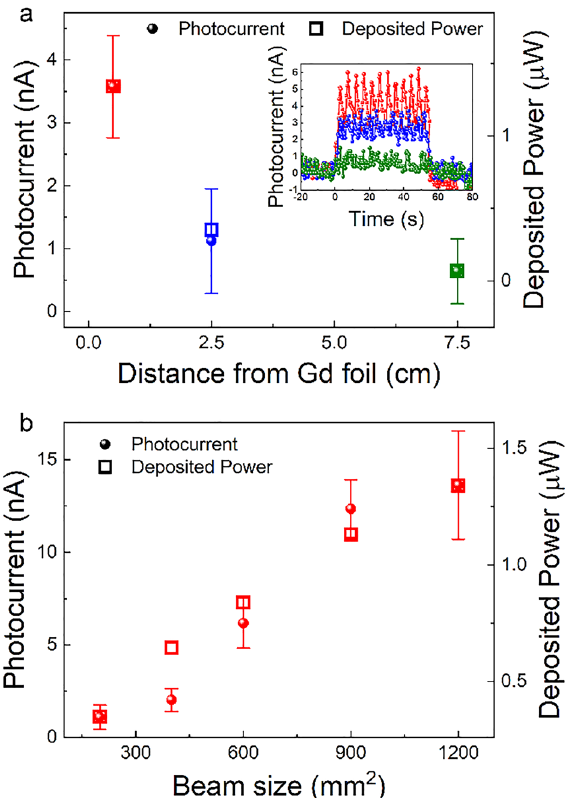
Figure 3. The dependence of the detected photo-current and the deposited power on: ( a ) the distance between the MAPbBr 3 SC and the Gd foil and ( b ) the neutron beam size. Measurements were performed under ambient conditions, using 1 V pulsed bias voltage (200 ms between pulses). Inset in ( a ) shows the measured photocurrent while opening and closing the neutron beam